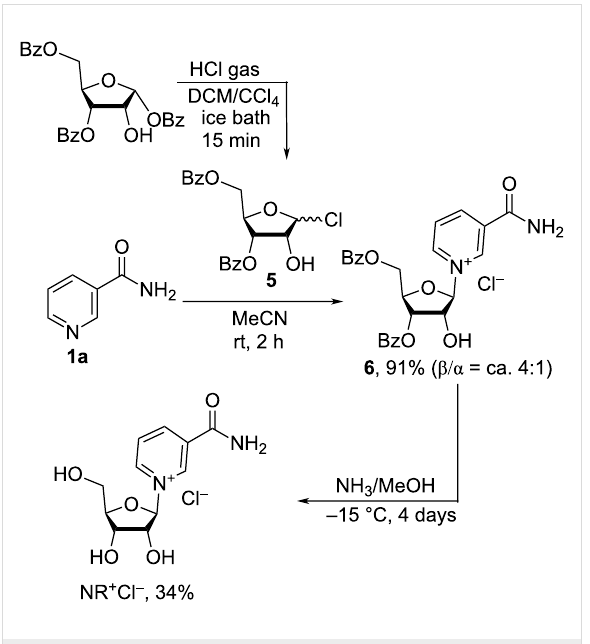
Figure 3: Predominant formation of β -anomer over α -anomer of NR + X − .